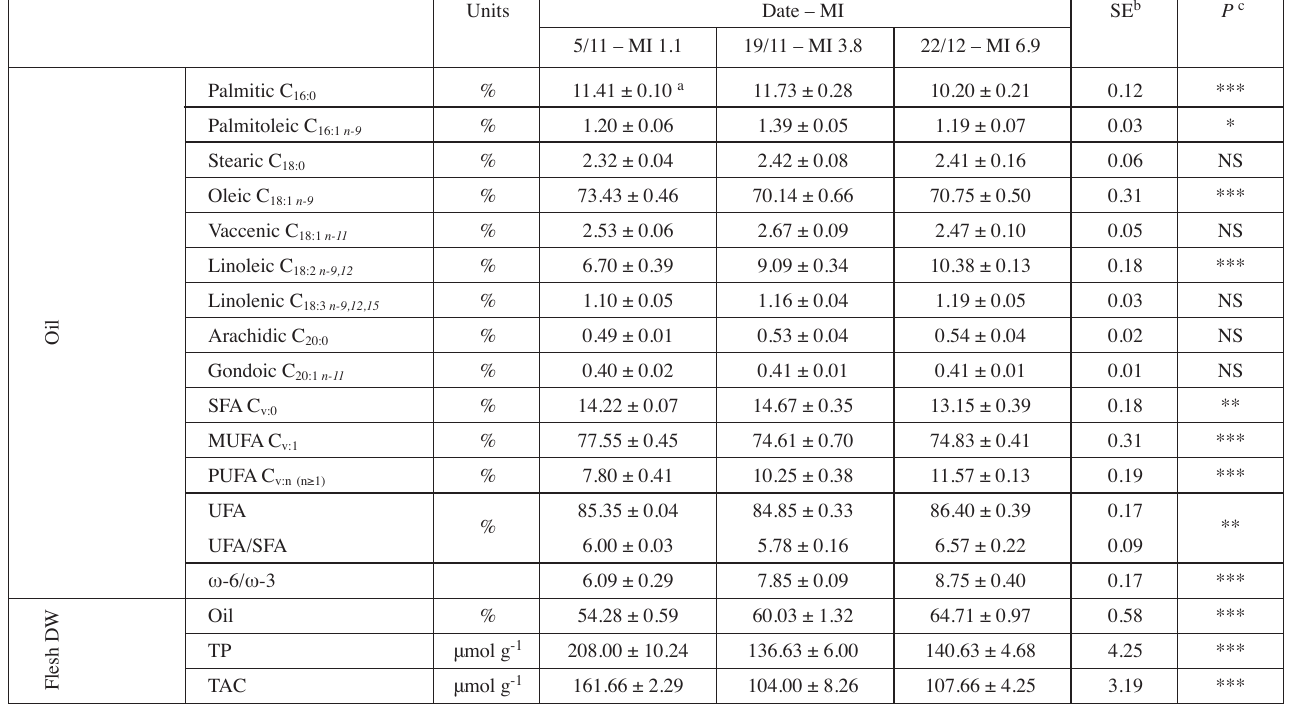
Tab. 1: Content of individual fatty acids (FA), total saturated (SFA), mono-unsaturated (MUFA), poly-unsaturated FA (PUFA) and total unsaturated FA (UFA), on the unsaturation degree (UFA/SFA) and ω-6/ω-3 ratios in oil, as well as, on oil content, total phenolics concentration (TP) and total antioxidant capacity (TAC) in the flesh in Koroneiki olive fruit, in response to seasonal development and fruit maturity indices (MI) in